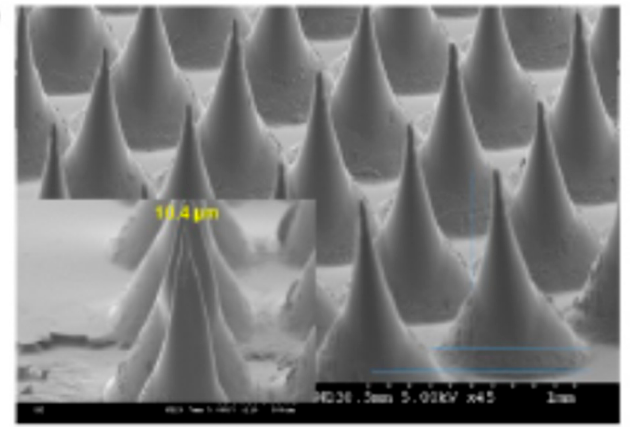
Figure 6. Scanning electron microscopy image of dissolving microneedles (MNs) containing DNA Polyplex Vaccine [4].